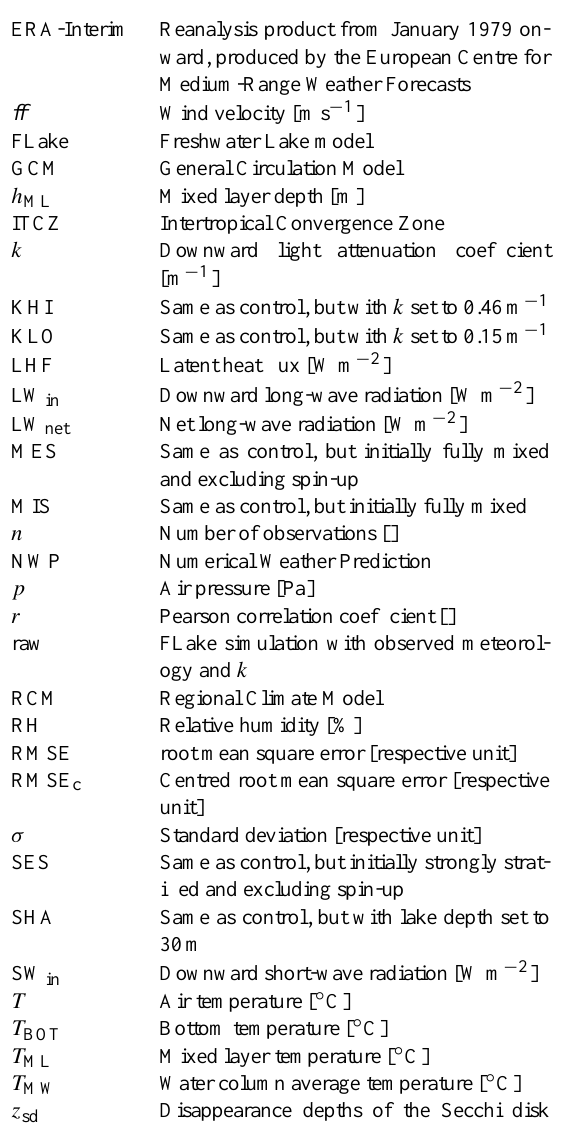
Table A1. Acronyms and variable